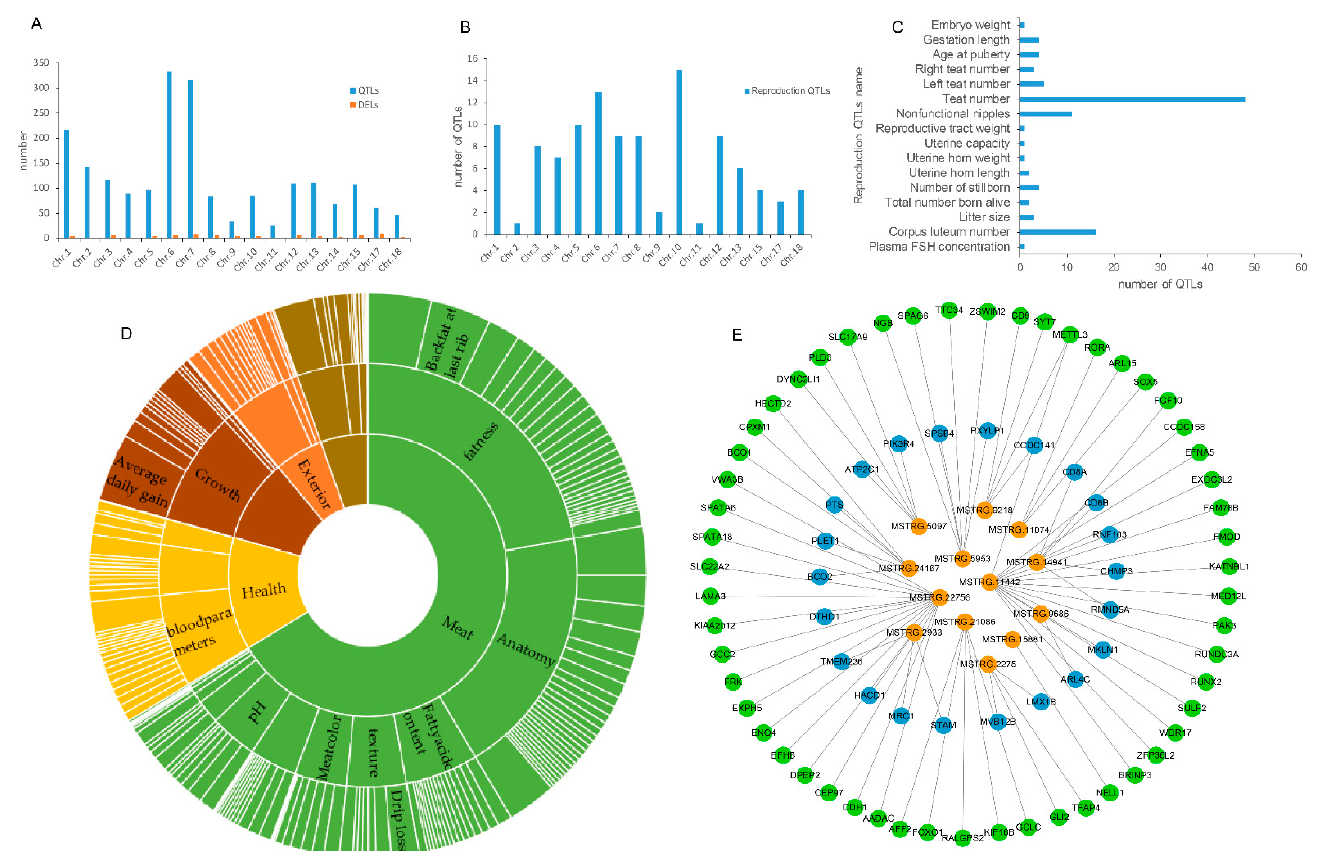
Figure 4. Function analysis of lincRNAs by QTLs. ( A ) Distribution of the DELs and QTLs on chromosomes. ( B ) Distribution of the reproduction QTLs on chromosomes. ( C ) The number of the reproduction QTLs. ( D ) Overview of the QTLs that were mapped onto the DELs. ( E ) Co-expression network of the DELs and their PTGs; the blue represents PTGs by cis-acting, and the green represents PTGs by trans-acting.